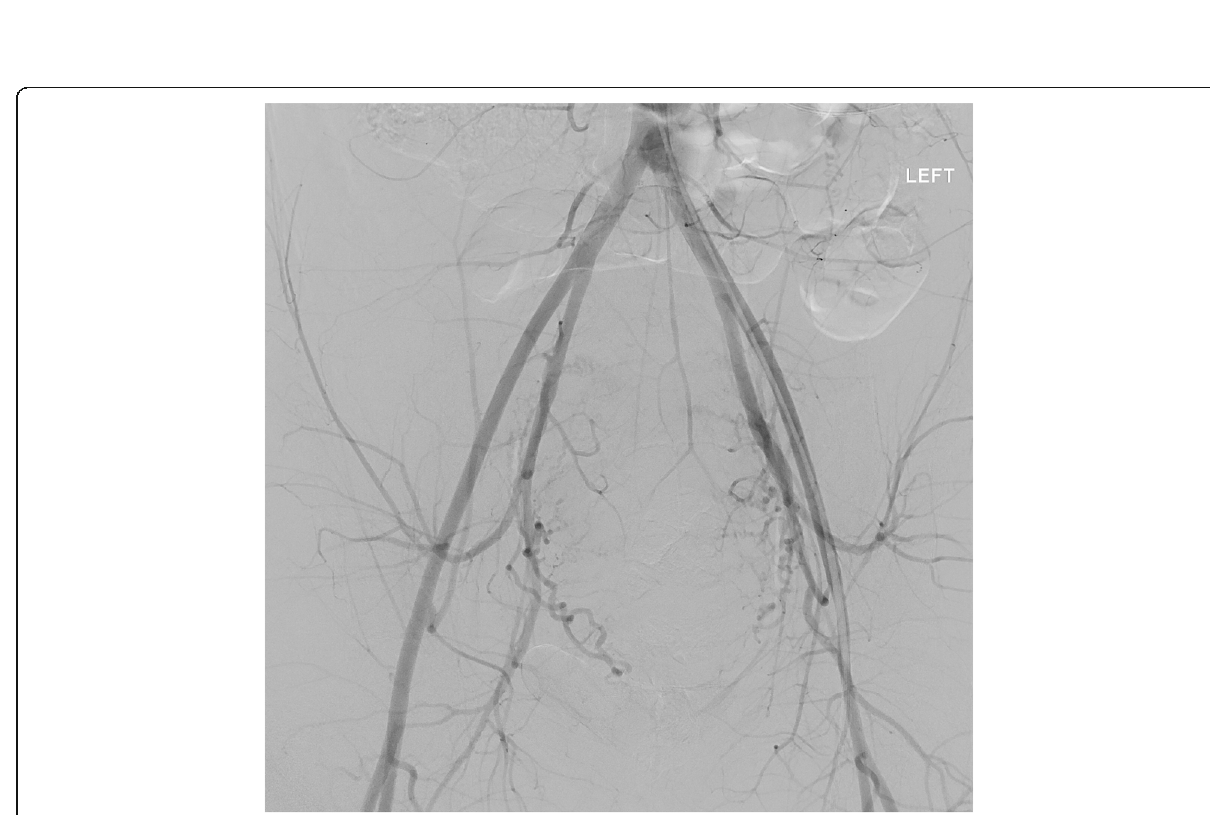
Fig. 10 Pelvic angiogram of the same patient as in Fig. 9 demonstrated no active extravasation. Subsequent subselection of the inferior epigastric artery also did not show any active extravasation on